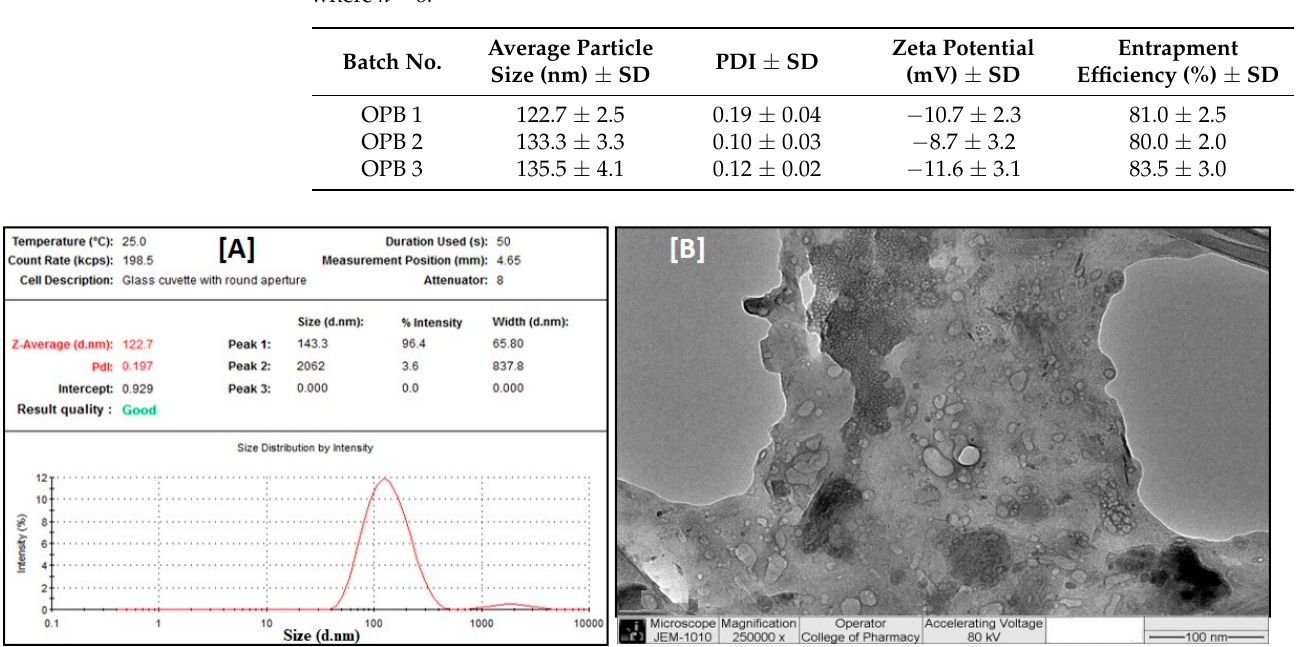
Figure 2. Particle size distribution ( A ) and TEM data ( B ) of liposomal preparation of the B. lacera leaf extract. Table 2. Average size, PDI, Zeta potential and entrapment efficiency of three optimized batches of liposomes prepared using similar conditions. Data are presented as mean ± standard error of mean, where n = 6.